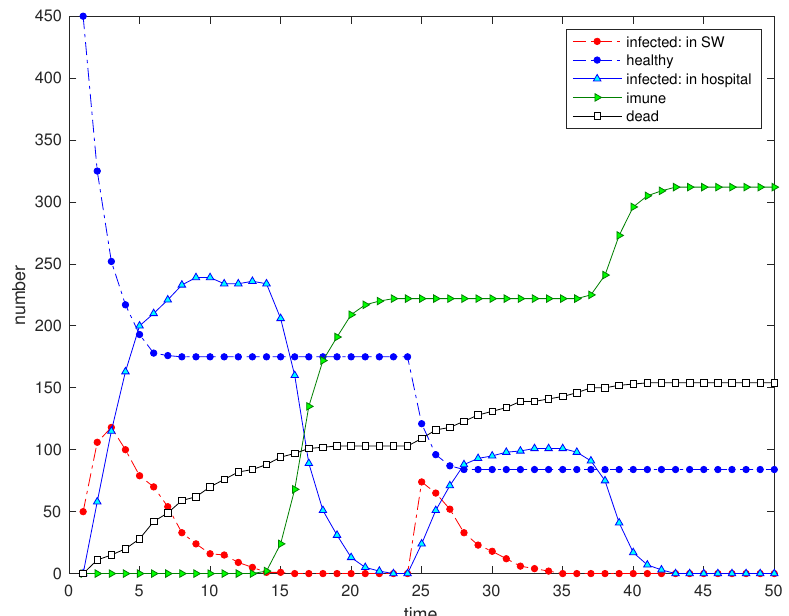
Figure 13. Scenario S 6 : Time evolution of the 5 state variables for D = 0.05 and a disturbance in the SW with the input of 50 new ‘infected’ visitors at t = 25 ( N = 500, n i = 50 at t = 1, δ = 0.1, p 1 = 0.1, p 2 = 0.9, p 3 = 0.7, p 4 = 0.05, p 5 = 0.02, α = 2 and N h → ∞ ).